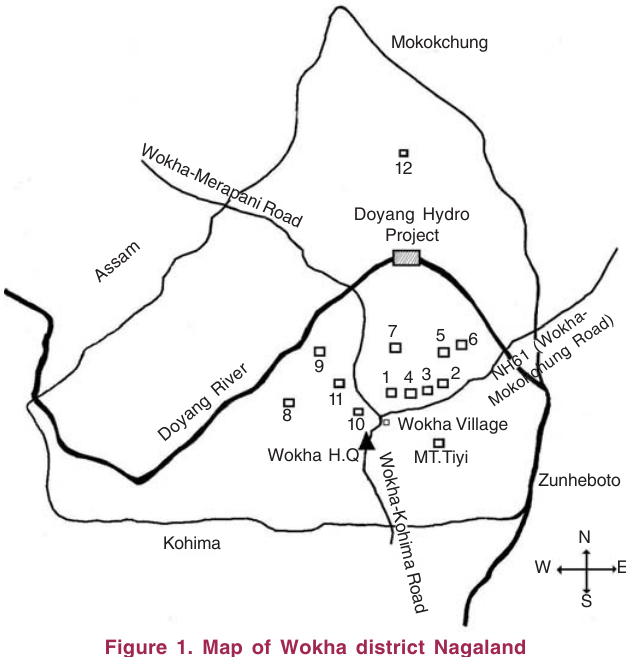
Figure 1. Map of Wokha district Nagaland 1 - Engorotchu; 2 - Kyotchu; 3 - Lungkitchu; 4 -